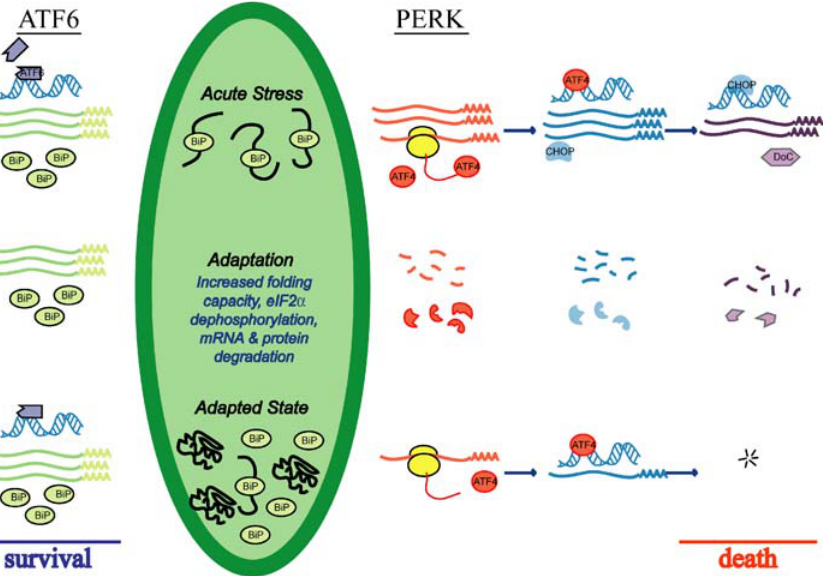
Figure 8. Model for Generation of an Adaptive Response to Chronic Stress The initial exposure of cells to ER stress leads to activation of all three proximal sensors of stress (only the ATF6 and PERK pathways are shown here) and up-regulation of UPR target genes. However, prolonged exposure to mild stress allows for adaptation, when selective degradation of mRNA and protein attenuates expression of CHOP and its downstream targets (DoCs), but not of ER chaperones like BiP. Increased BiP levels in the ER facilitate adaptation, both by assisting protein folding, and probably by binding to, and thereby inhibiting activation of, the proximal sensors. An adapted state might be characterized by low-level activation of the sensors, that is sufficient to maintain elevated BiP protein levels, but not of CHOP or GADD34. See text for further details. DOI: